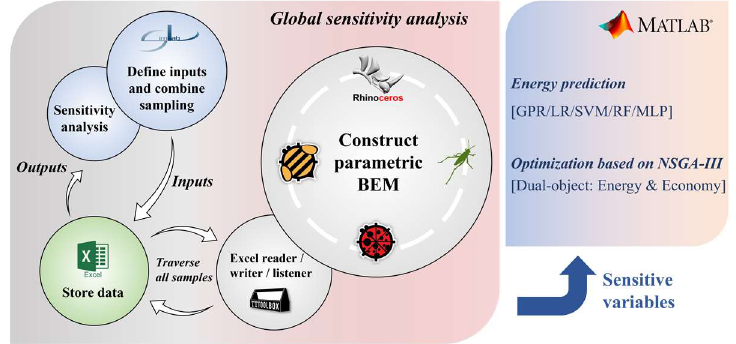
Figure 2. Flow chart of sensitivity analysis and subsequent research.